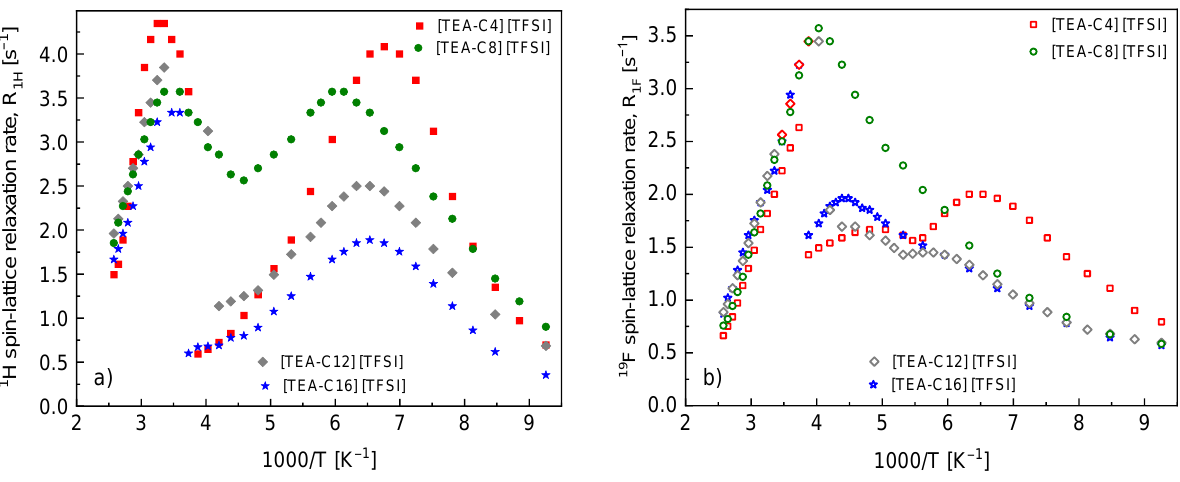
Figure 1. 1 H ( a ) and 19 F ( b ) spin-lattice relaxation rates versus reciprocal temperature for [TEA- C4][TFSI], [TEA-C8][TFSI], [TEA-C12][TFSI] and [TEA-C16][TFSI].